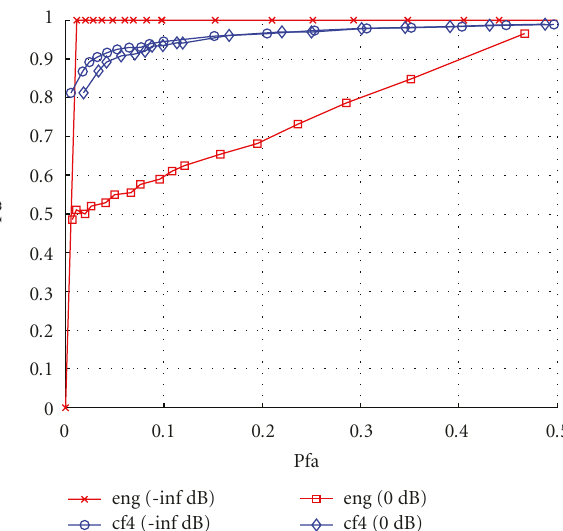
Figure 5: Energy, second-order and fourth-order detector proba- bility of missed detection (the solid lines) for a fixed probability of false alarm (the points at 10 − 1 ). The system parameters are: baseband QPSK signal with 20 MHz symbol frequency, 40MHz sample frequency, square-root Nyquist pulse shaping filter of 0 . 2 roll-o ff factor. No noise uncertainty added. The second-order detector is set to detect the symbol-rate feature (cf = 20 MHz), and the fourth-order detector works with the feature at four-times the carrier frequency, which is equal to zero in the present situation (cf = 0MHz).Two observation times are considered for the three detectors: 50 and 500 μ s. An observation time of 10 ms has been added for the fourth-order detector